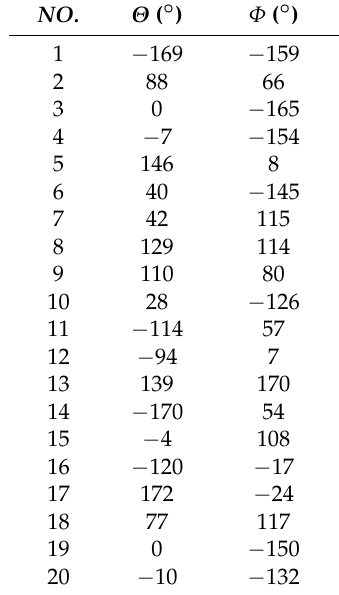
Table 2. Random sampling values of parameter set ( Θ , Φ ).